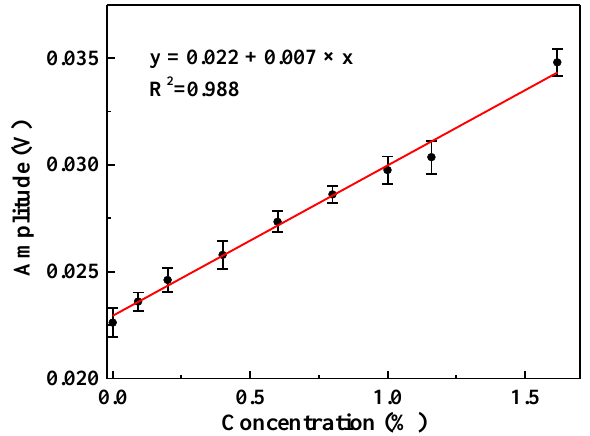
Figure 10. The fitting curve of the relationship between the absorption signal amplitude and H 2 O concentration within the range of 0–1.6%.